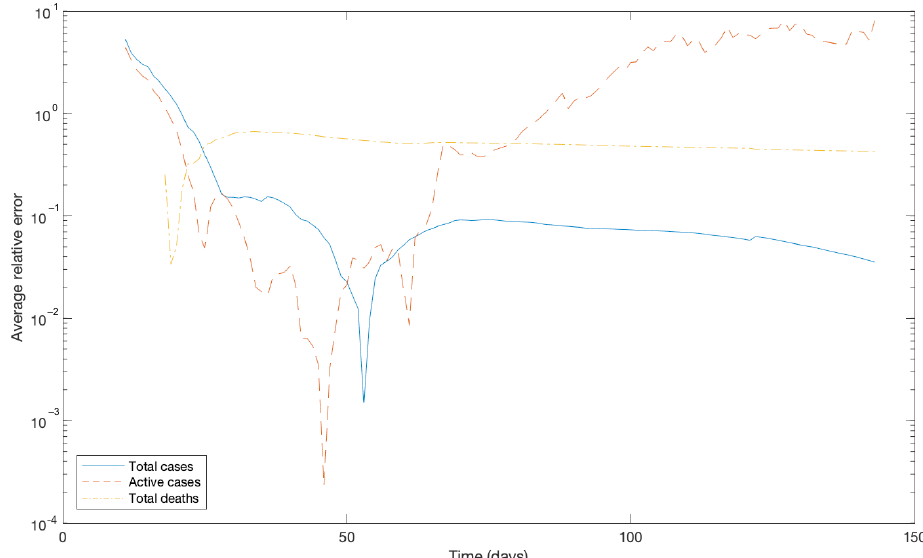
Figure 4. Average relative error of the simulation approach against the real life data in log scale.